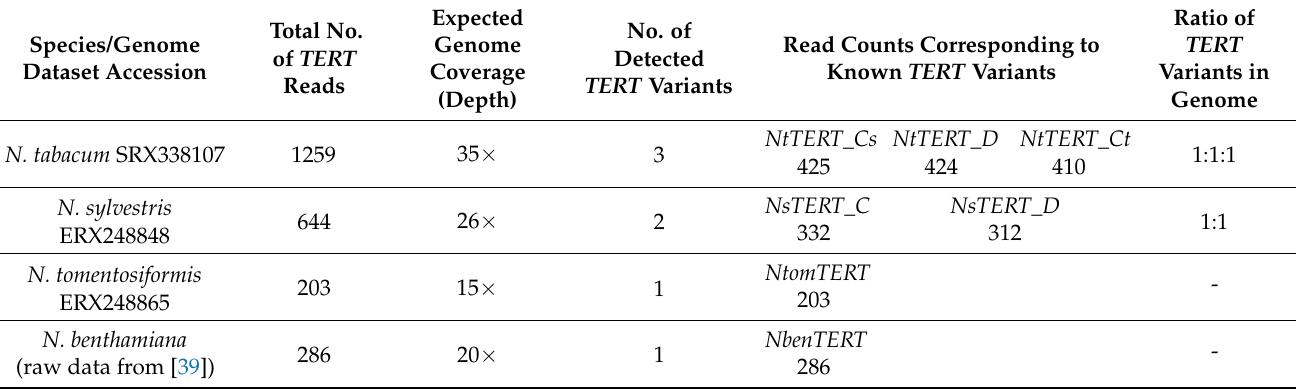
Table 2. Number of TERT gene copies in Nicotiana species determined in